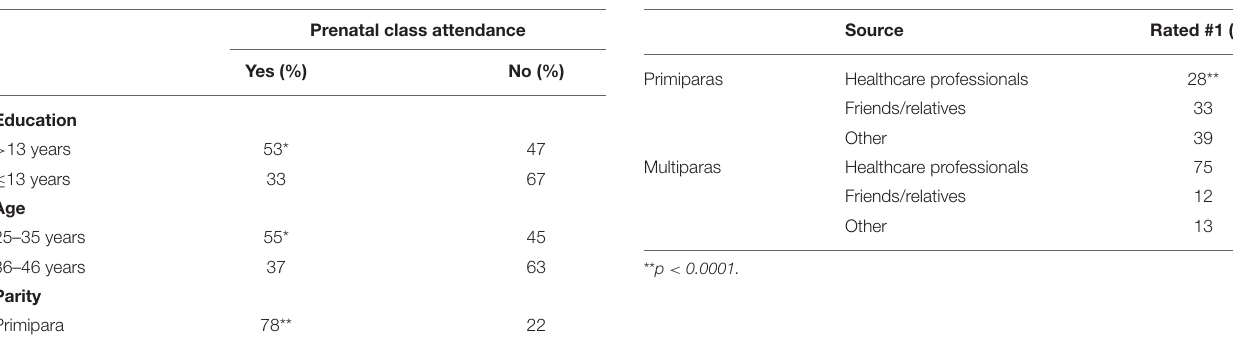
TABLE 6 | Association between parity and primary source of information on